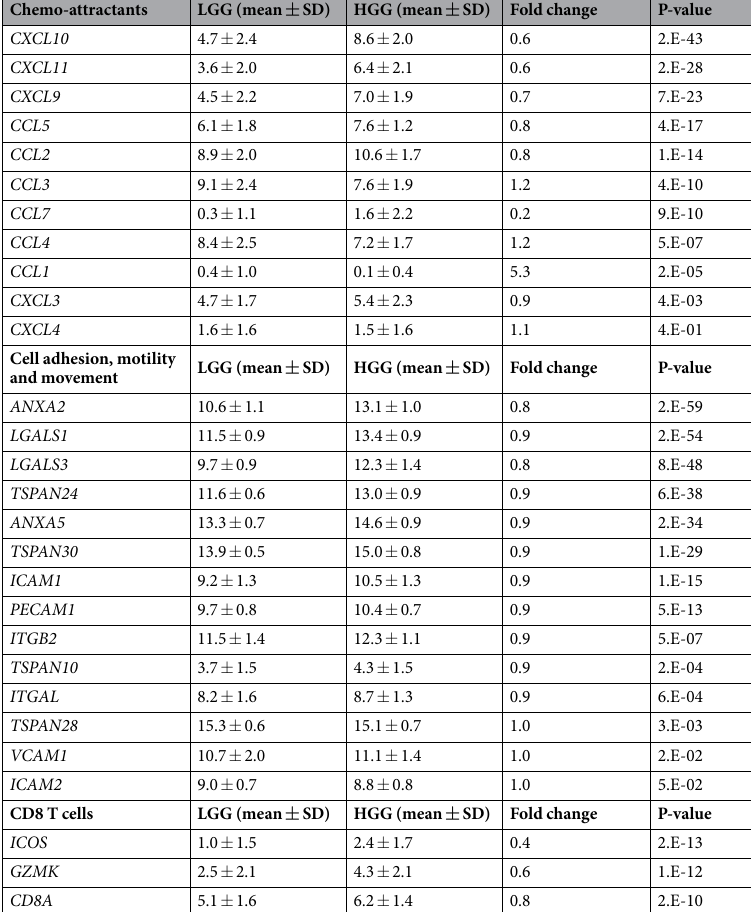
Table 1. Expression of T cell recruitment genes in LGG and HGG. TCGA gene expression data of molecularly defined LGG and HGG cases (LGG: n = 232, HGG: n = 246) were used from the University of California Santa Cruz Cancer Genome Browser (available at http://www.cbioportal.org/). LGG and HGG cases were compared for expression levels of differentially expressed C, CC, CXC and CX3C chemo-attractants, adhesion molecules (including integrins, annexins, galectins, tetraspanins) and genes associated with CD8 T cell activation. Mean expression values ± SD for each gene are shown as log2 (FKPM) and LGG vs HGG are tested using T